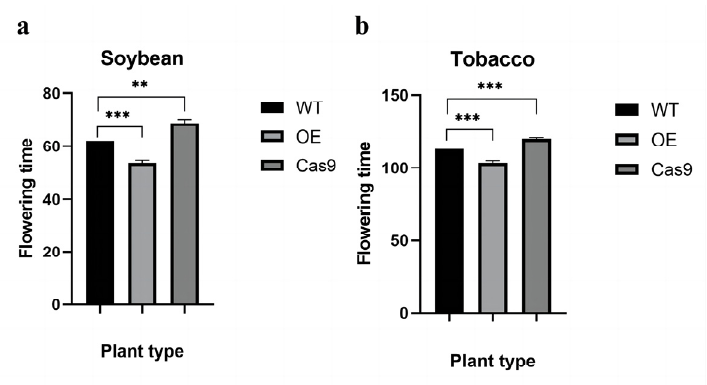
Figure 8. Comparison of flowering time between T2 generation of positive transgenic soybean plants ( a ), T2 generation of positive transgenic tobacco plants ( b ) and wild-type plants.Significant differences according to Student’s t -test are indicated. ** and *** indicate significant differences at p < 0.01 and p < 0.001 levels, respectively. All data shown are means ± SD of three biological replicates.